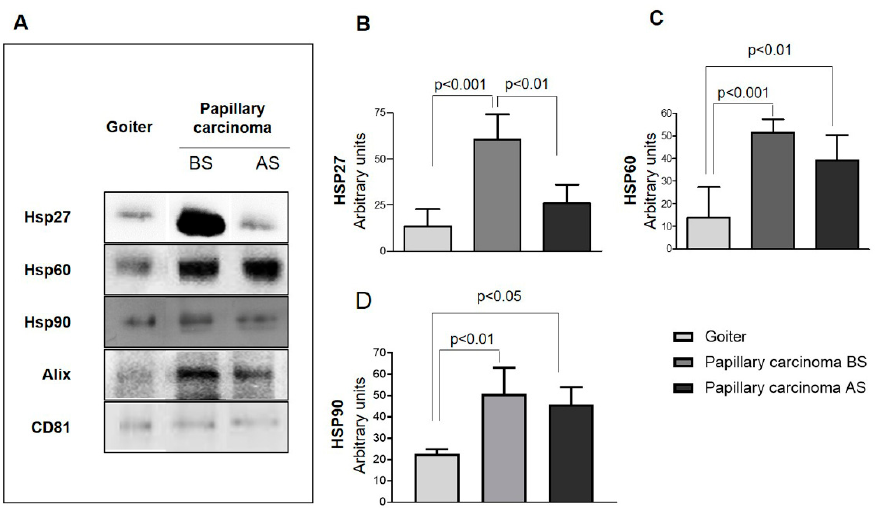
Figure 4. Western blotting data on molecular chaperones in exosomes. ( A ) Western blots showing the presence and levels of Hsp27, Hsp60, and Hsp90 in the exosomes studied. Visible are the higher levels of Hsp27, Hsp60, and Hsp90 in the exosomes from plasma from patients with papillary carcinoma before surgery (BS) compared with those obtained from either the same patients after surgery (AS) or from patients with goiter. The difference of Hsp27 levels between patients with papillary carcinoma BS and AS and with goiter was statistically significant ( B ), whereas Hsp60 ( C ) and Hsp90 ( D ) levels in patients with papillary carcinoma BS and AS were statistically significant when compared with patients with